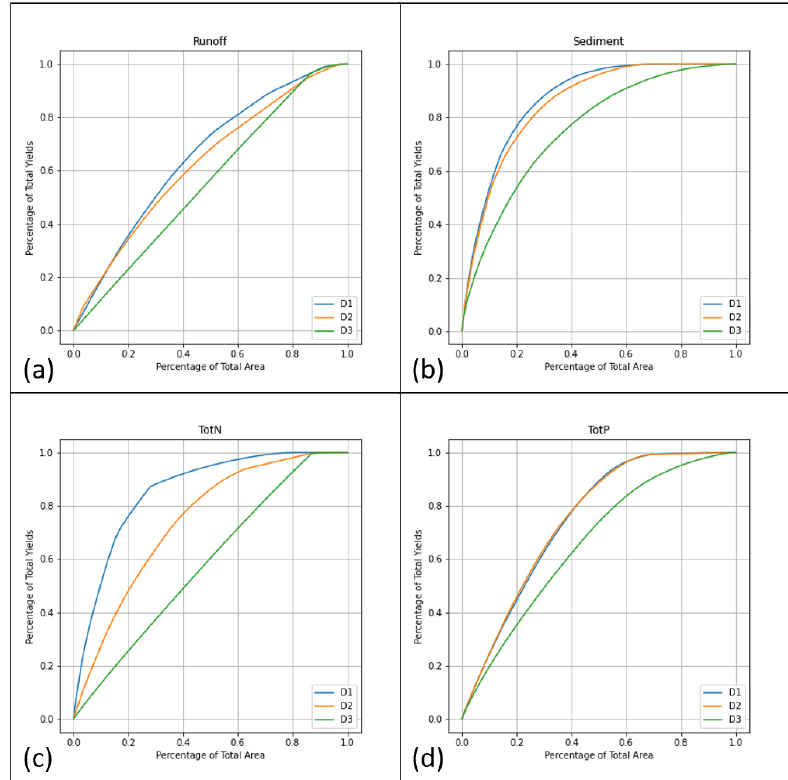
Figure 9. Mass-area ratios of ( a ) surface runoff (SurfQ), ( b ) total sediment (Sed), ( c ) total nitrogen (Tot N), and ( d ) total phosphorus (Tot P) among three synthetic watersheds: (D1) synthetic natural watershed, (D2) synthetic agricultural watershed, (D3) synthetic urban watershed.